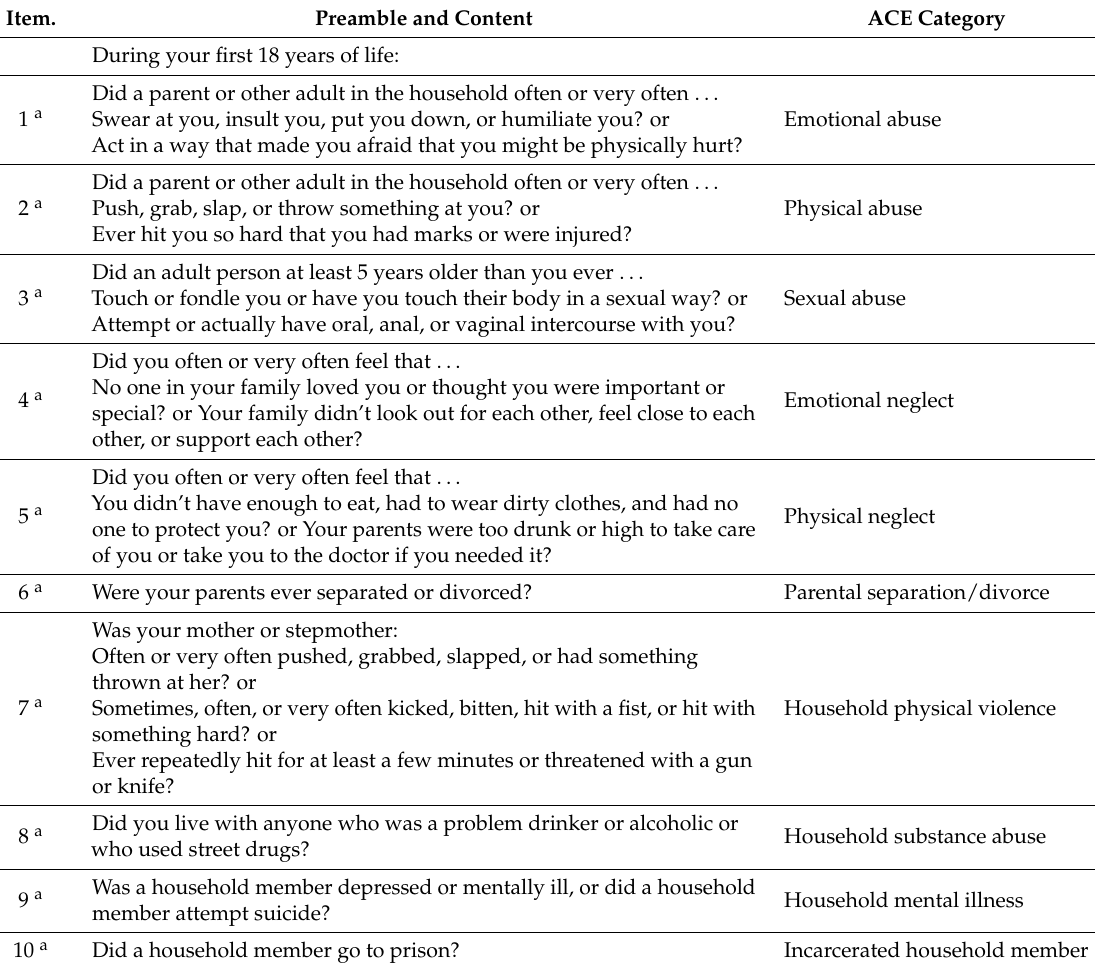
Table A1. The ACE Score Calculator—preambles, item contents and response